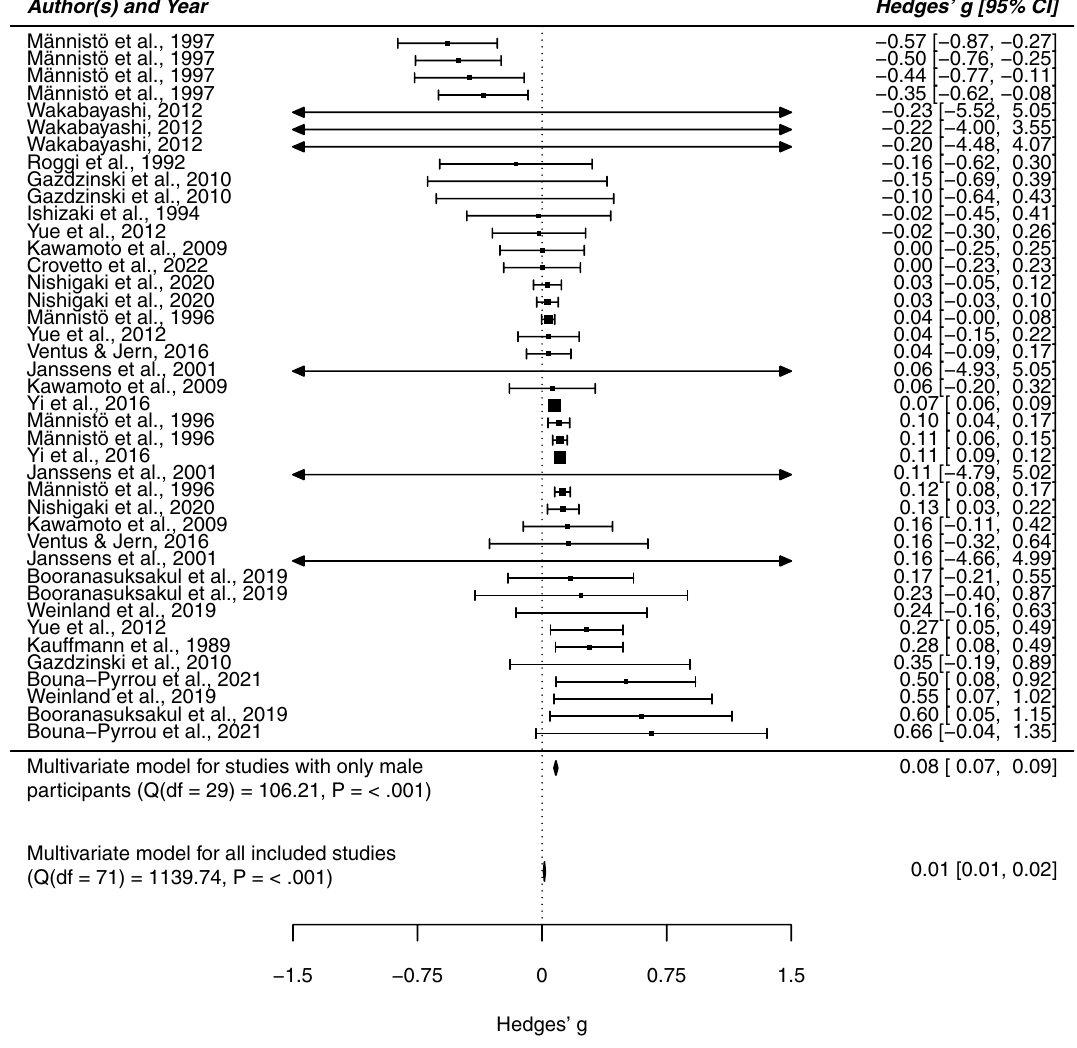
Figure 2. Forest plot of the standardized mean difference in BMI among male drinking and non-drinking subjects. This plot shows the results of the individual studies examining males together with their 95% confidence interval (CI). The weight of each study contributing to the overall effect is illustrated by the size of the square. The summary polygons at the bottom of the plot show the results from the multivariate meta- analytic model for (1) the subgroup of males and for (2) all included